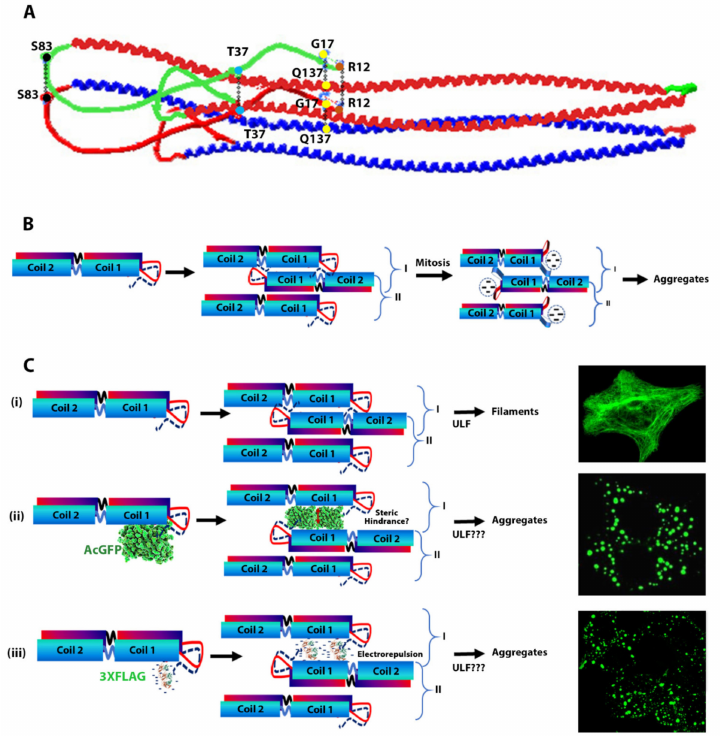
Figure 8. ProposedmechanismofaggregationbyN-terminallytaggedvimentin. ( A )Vimentintetramer structure in which the rod domains of two dimers (red and blue) associate in a staggered fashion. The head domain (shown in green for one dimer and red for the other dimer) folds back onto the rod domain causing G17 of the head domain to interact with Q137 of coil I (residues highlighted as yellow dots) (modified from [42]). ( B ) Schematic representation of the two possible ways (I and II) dimers can associate into a tetramer. The N-terminus of the vimentin head domain has a large number (8 out of 26) of serine/threonine residues, phosphorylation of which during mitosis or calyculin A treatment causes repulsion between the head domains leading to disruption of association between head–head and head–rod including G17 and Q137 interaction. This causes conformational alterations leading to collapse of the network. ( C ) i . Eight tetramers (both types I and II) association to form ULFs which further associate into mature filaments; ii . Tagging the head domain at the N-terminus with AcGFP, which is a larger tag (239 residues; 27 kDa), will therefore interfere with head–head, head–rod and rod–rod interactions (shown by a double arrow) when the head domains fold back, due to steric hindrance, and is likely to have the same effect as induced by phosphorylation of serine/threonine residues located at the N-terminus. This may affect ULF formation or render them incapable of associating into filaments; iii . When vimentin is tagged at the N terminus with 3 × FLAG, a much smaller tag of only 22 residues, aggregates are still formed. This can be explained by the fact that 11 out of 22 residues in 3 × FLAG are aspartic acid making the tag peptide acidic (pI = 3.97), which will create extensive repulsion disrupting not only the head–rod interactions but also inter-rod interactions affecting formation of ULF or making them unable to associate into filaments (redrawn and modified from reference [33]). The proposed mechanism of aggregation by N-terminally tagged vimentin is summarised in Supplementary Video